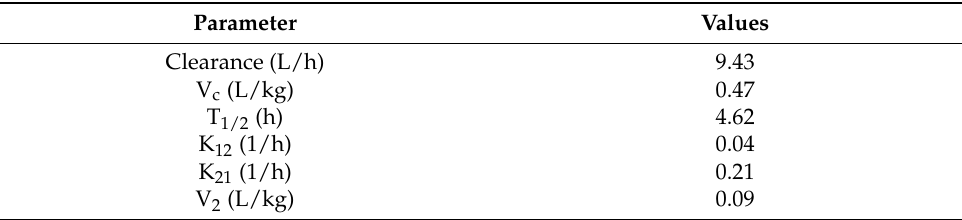
Table 3. PK parameters obtained from two-compartment model fitting of oral solution (10 mg) of Riva.